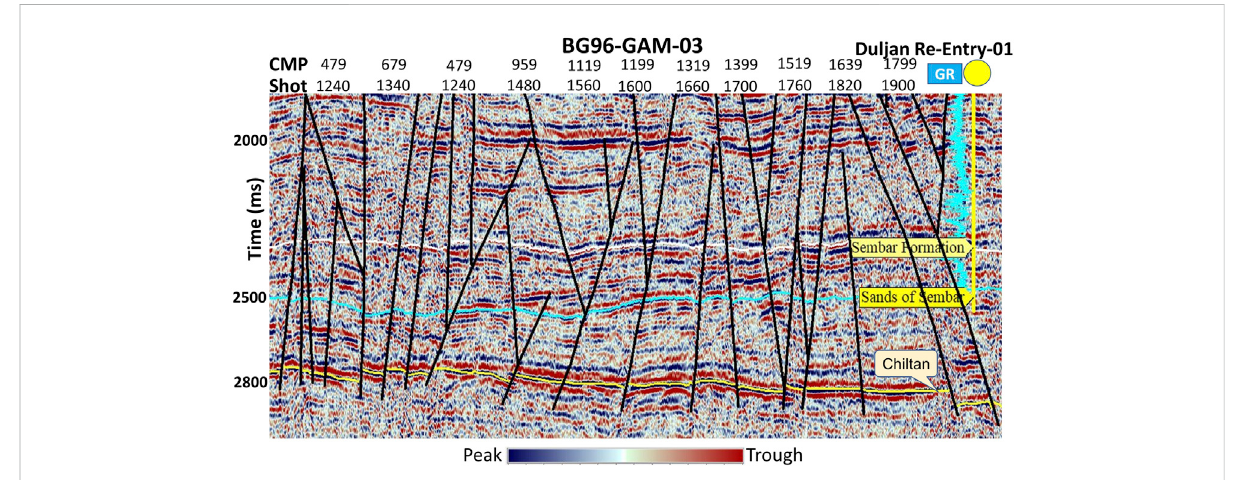
FIGURE 8 Interpreted seismic line BG96-GAM-03 of the Gambat block with GR log superimposed on it along with marked horizons and faults on